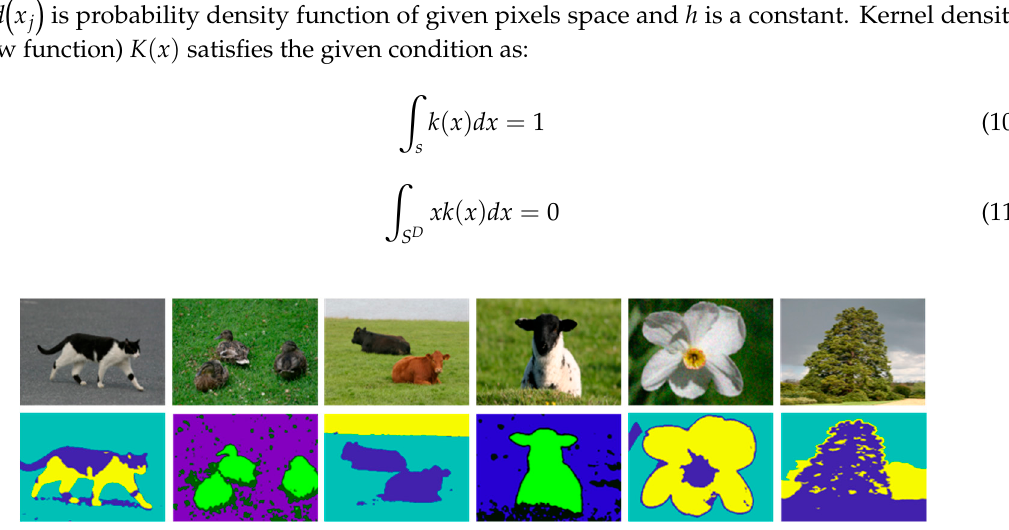
Figure 5. Results of Mean shift-based segmentation. The 1st row shows the original while the 2nd row shows the segmentation results.